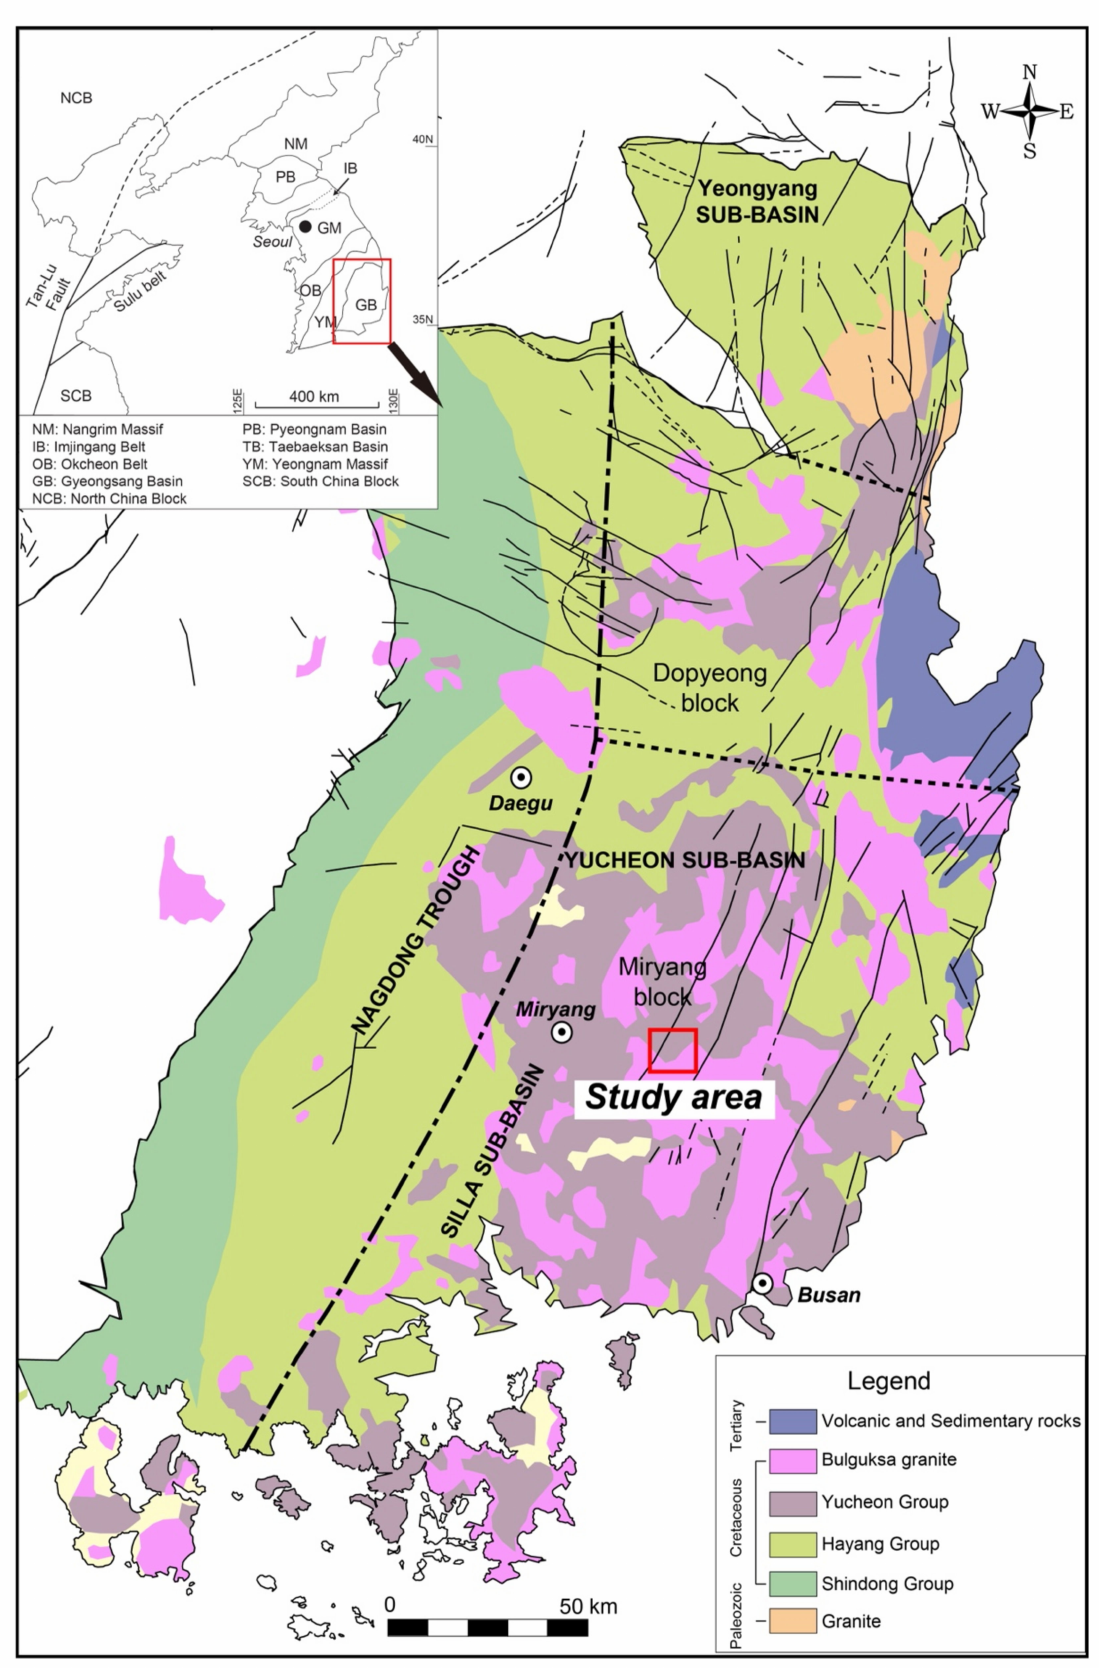
Figure 1. Geologic map of the Gyeongsang Basin in South Korea and location of the study area (modified from